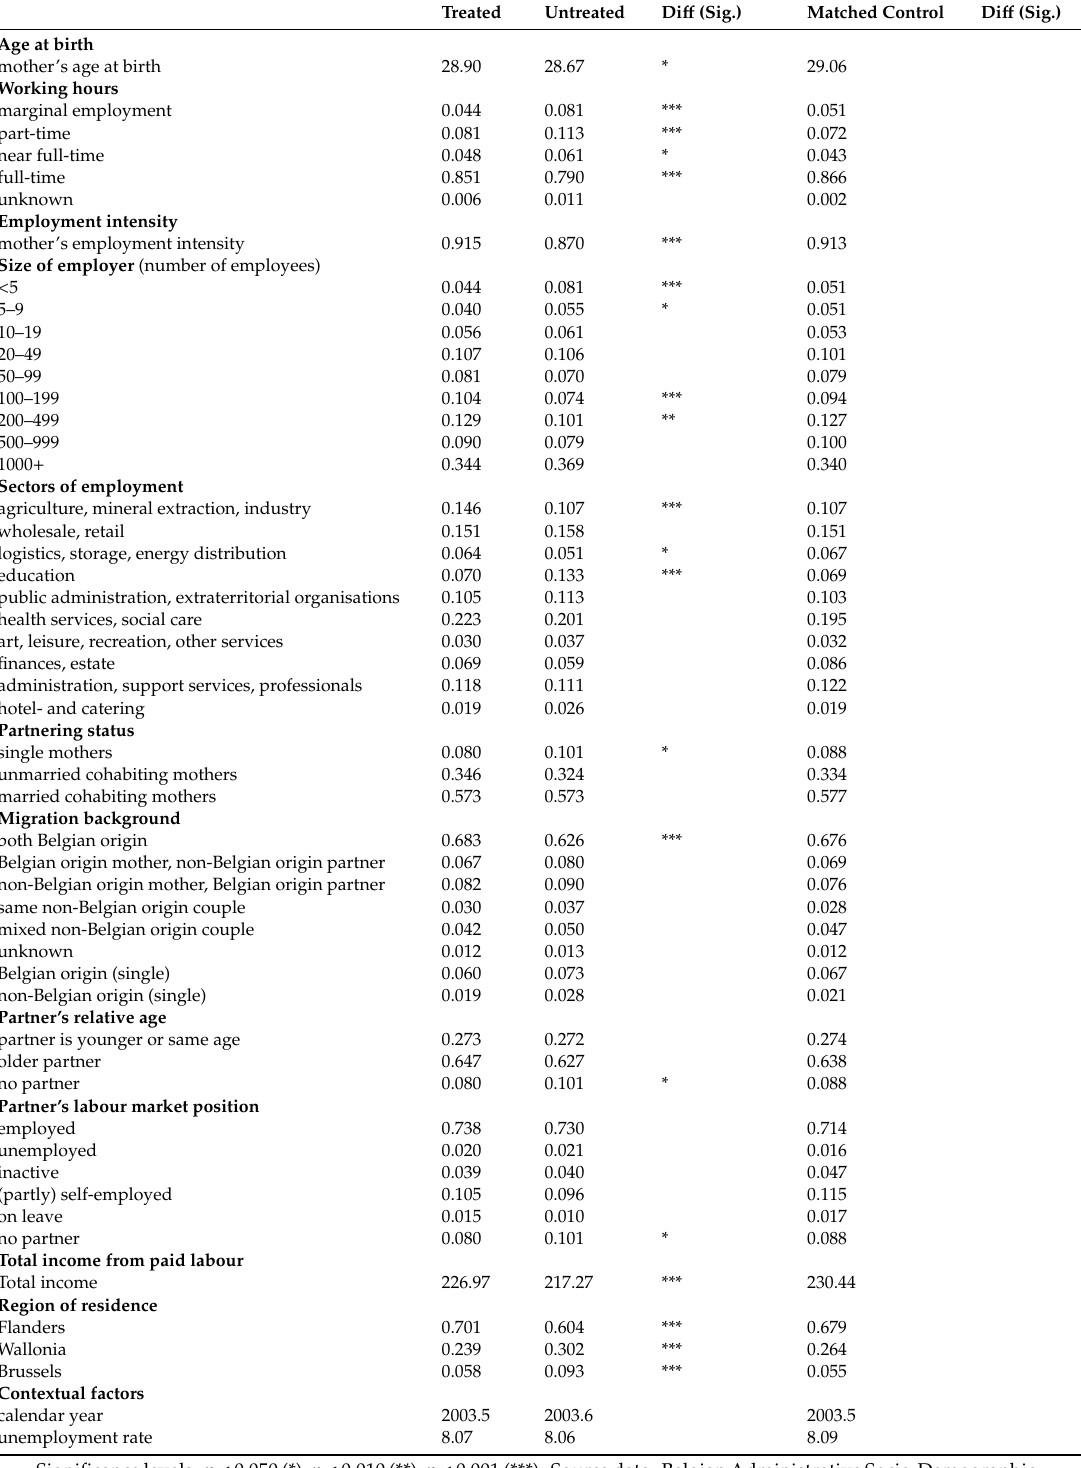
Table 1. Sample characteristics (means and proportions) for 4742 women who experienced a first birth in 2001–2005, Belgium. Treated Untreated Di ff (Sig.) Matched Control Di ff